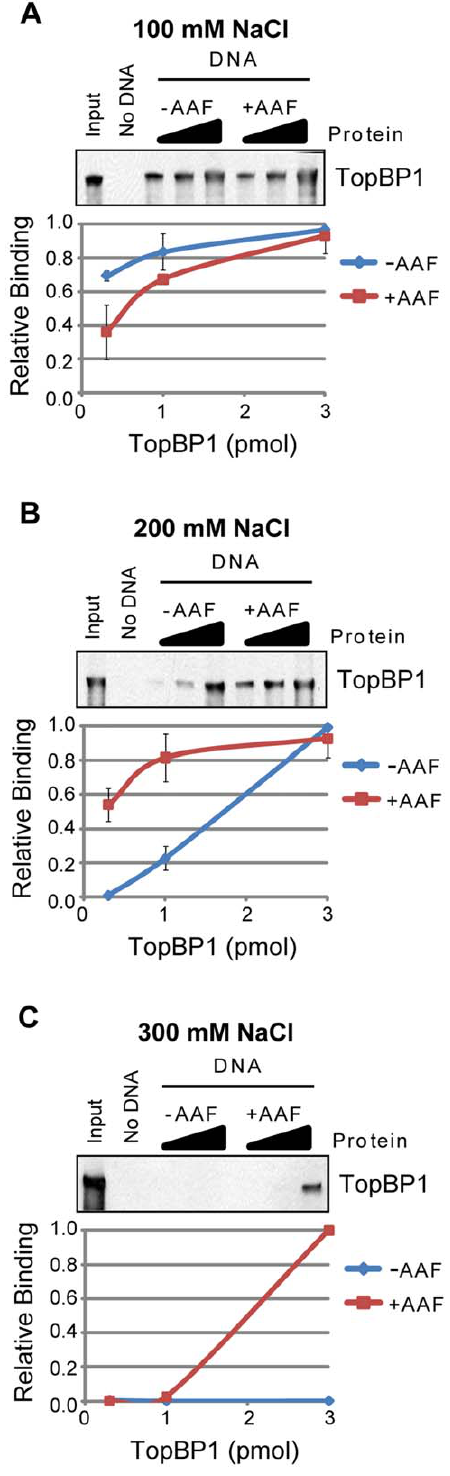
Figure 9. Effect of ionic strength on discrimination of damaged and undamaged DNA. The association of each of TopBP1 with beads alone (No DNA) or to undamaged ( 2 AAF) or AAF-damaged ( + AAF) plasmid DNA bound to magnetic beads was analyzed by SDS-PAGE and immunoblotting. Binding reactions contained either (A) 100 mM NaCl, (B) 200 mM NaCl, or (C) 300 mM NaCl. Reactions were carried out as described in the Methods section.